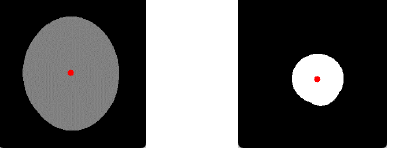
Figure 4. Illustration of the estimated centroids of optic disc ( left ) and optic cup ( right ), which have been marked in